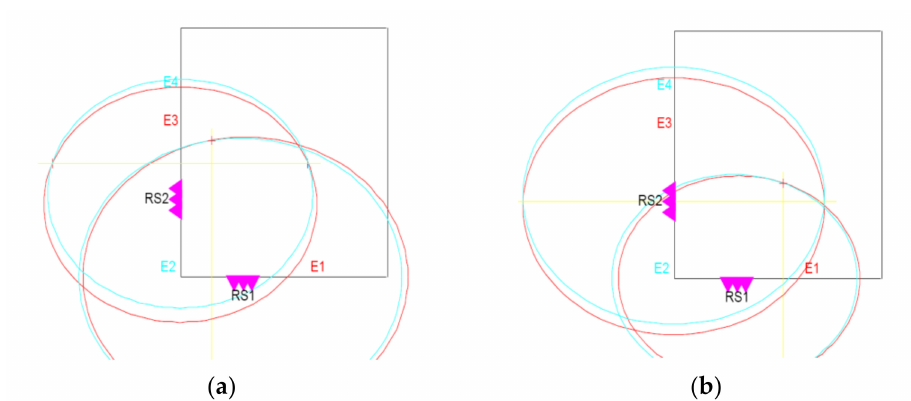
Figure 4. Position of lines of RS1 and RS2 sets in the points ( a ) τ = 55 and ( b ) τ = 100.